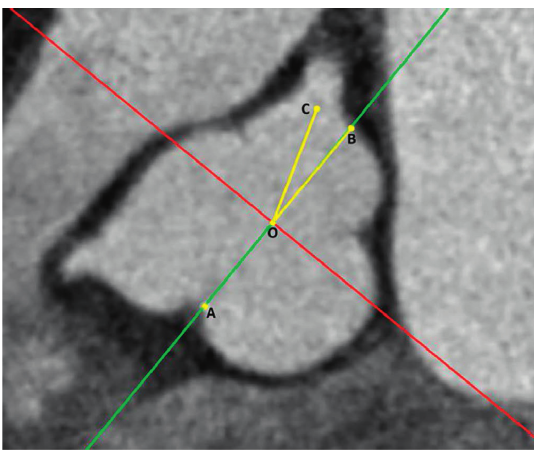
Figure 4: Definitions of the angle between the LMCA ostium and the NCC-RCC commissure. ‘Dot A’ was at the NCC-RCC commissure. ‘Dot O’ was at the center of the cusp plane of the aortic valve. ‘Dot B’ was at the opposite side of dot A on the cusp plane. ‘Dot C’ was at the center of the LMCA ostium. The angle between the LMCA ostium and NCC-RCC commissure was ∠ BOC. The LMCA ostium was considered to be facing the NCC-RCC commissure when ∠ BOC was equal to 0 °